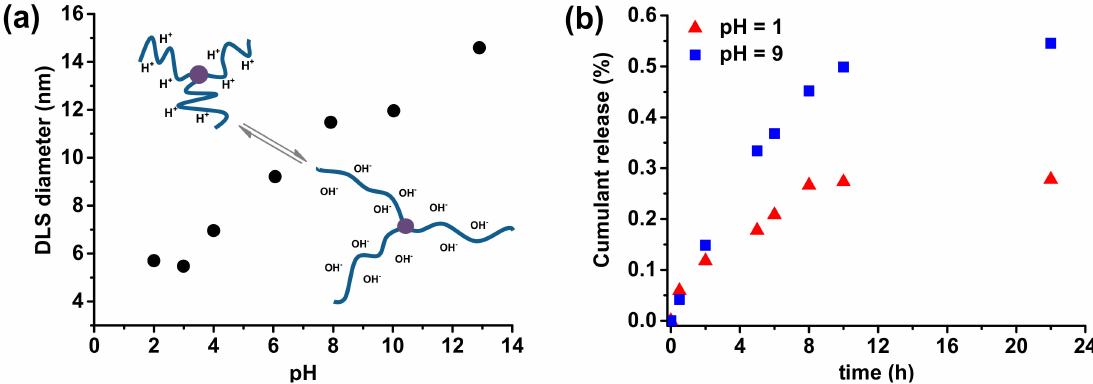
Figure 6. ( a ) DLS diameters of rifampicin-based macromolecules with PAA side chains (Table 1, entry 5 after acidic hydrolysis) at varying pH with a schematic representation of possible polymers configurations, ( b ) Quercetin release profile from rifampicin-based micelles in di ff erent pH bu ff er solutions at 37 ◦